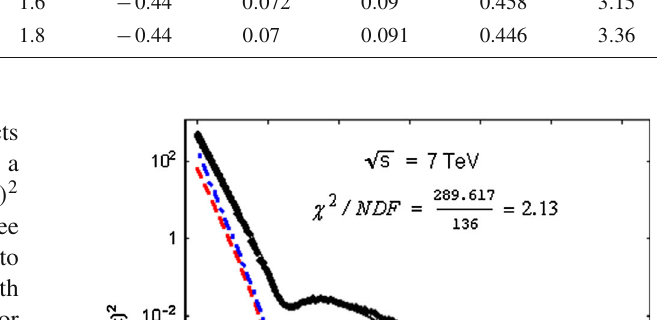
Table 1 The dimensionless values of α 0 = R 2 parameters A 0 , ε and β 0 , three-quark force parameters A , B and γ 0 and cloud parameters B 0 and c 0 . R 2 √ s , TeV